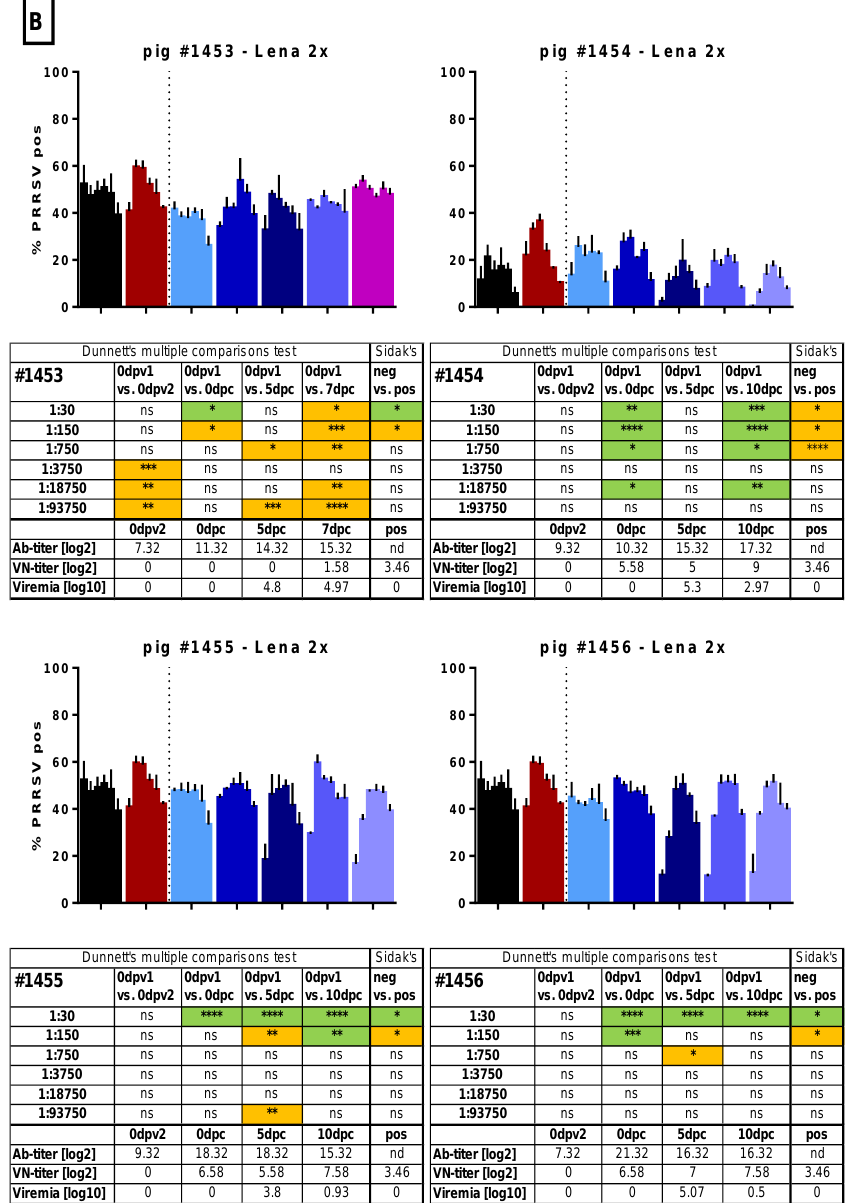
Figure 5. Macrophage infection in the presence of immune sera. Sera of several randomly selected pigs from the different groups were tested for their ability to enhance the infection of monocyte- derived macrophages (MDMs). Serial dilutions (1:30 to 1:93,750) of the sera were pre-incubated with Lena.